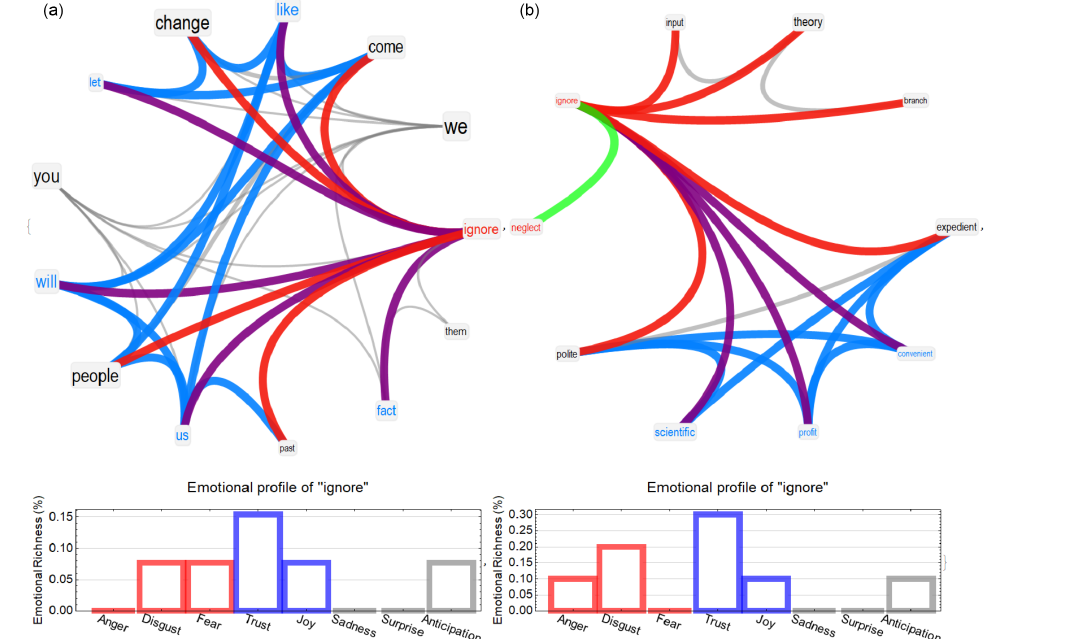
Figure A7. Speakers’ mindset reconstruction around “ignore” in the speeches of Greta Thunberg (a) and Christopher Monckton (b) . We refer the reader to Fig. 1 for a detailed explanation of the colour code and to Lexicon 1 for an interpretation of the figure.